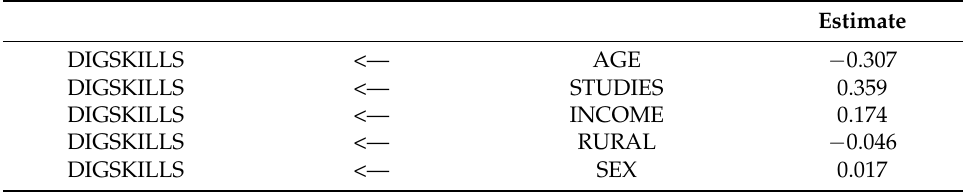
Table A11. Standardized Regression Weights: (Group number 1-Default model).